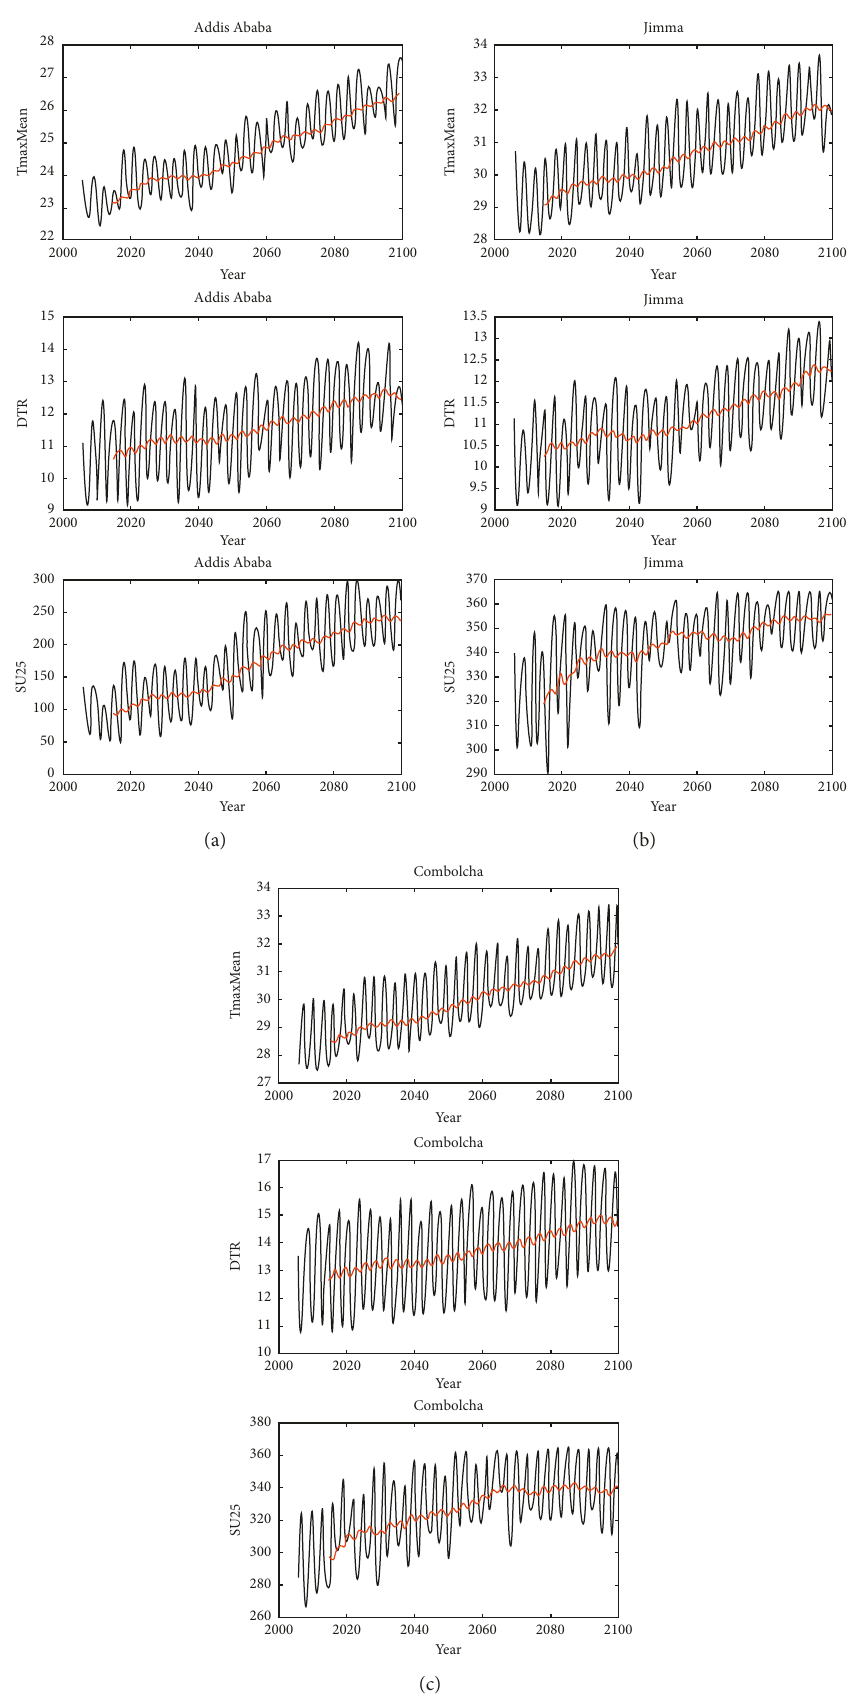
Figure 11: Ten-year moving average (red line) and time-series plot of projected TMAXmean (a), DTR (b), and SU25 (c) of temperature